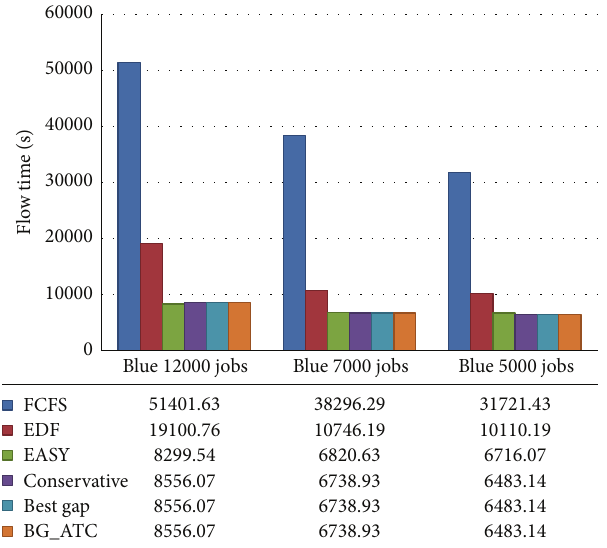
Figure 13: Flow time performance analysis on blue